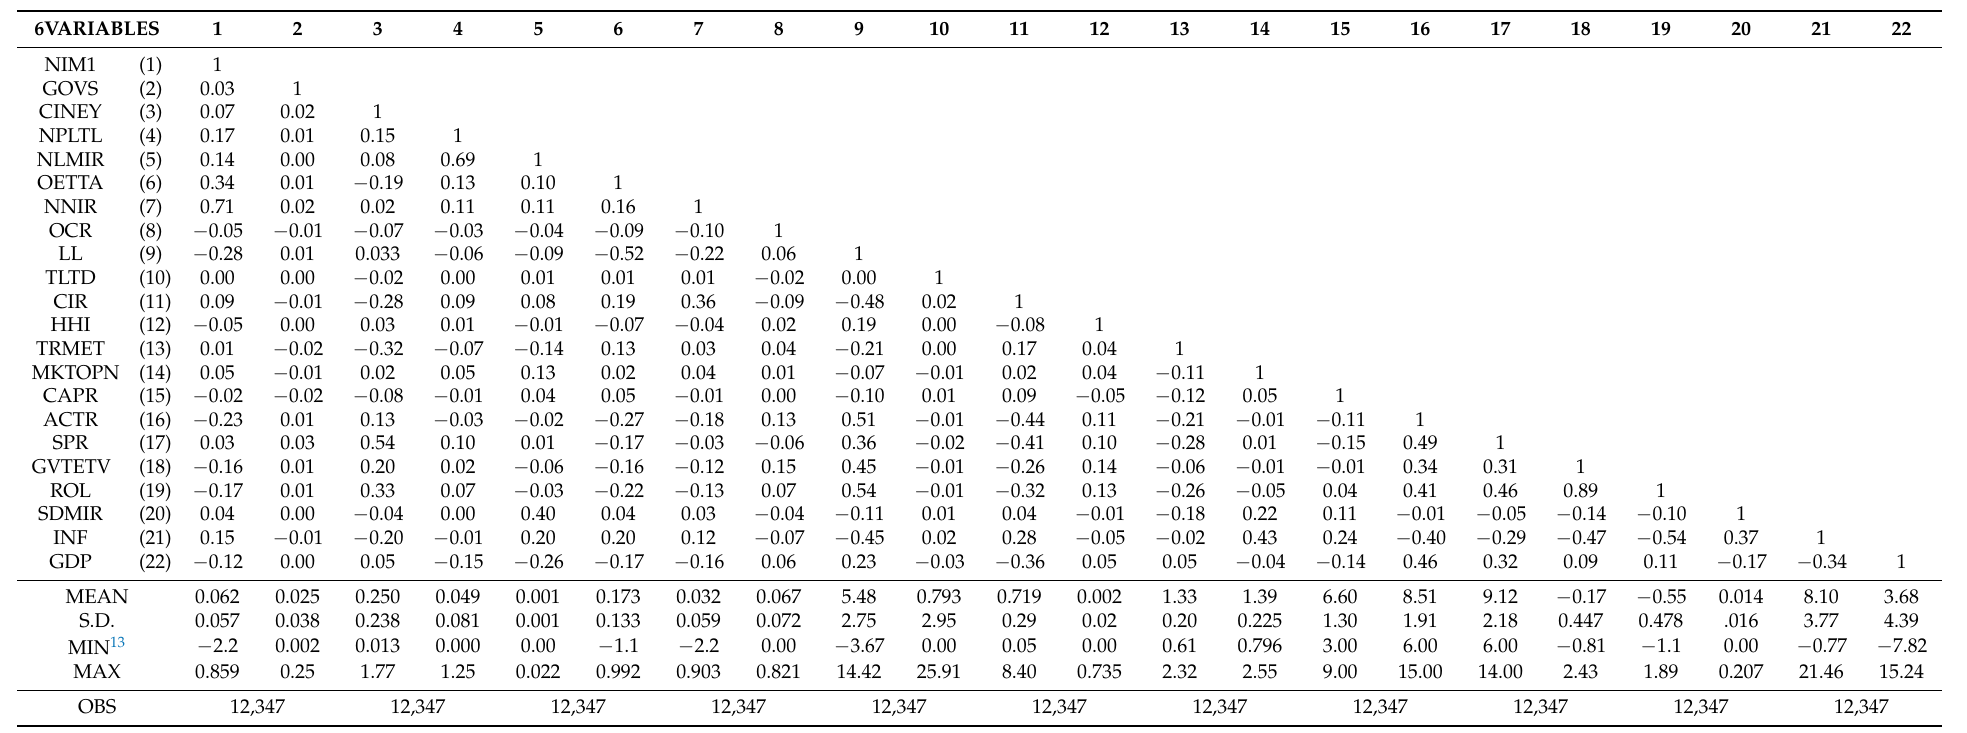
Table 2. Summary statistics and correlation matrix (Total